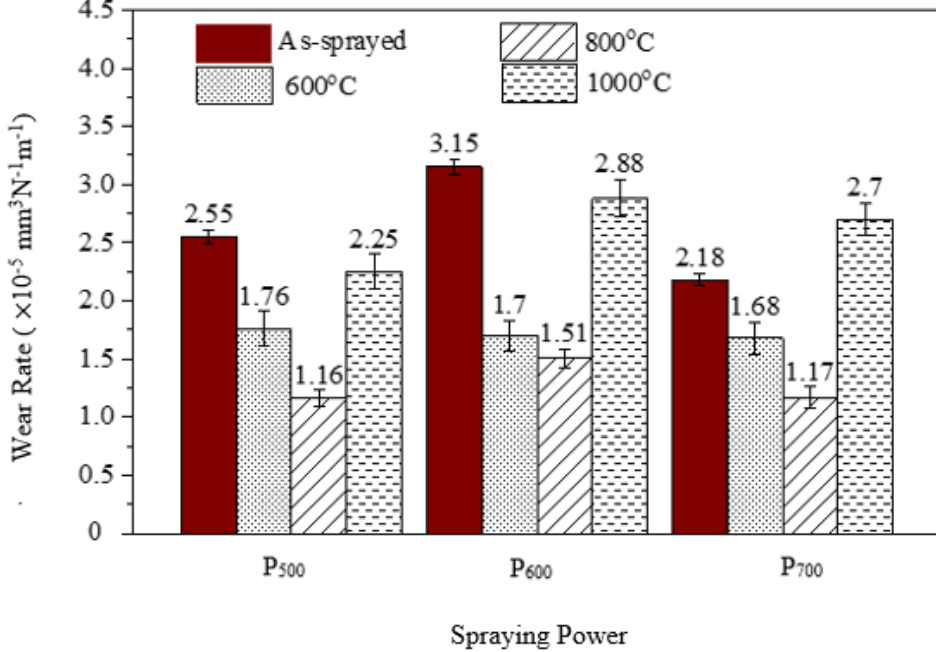
Figure 9. Volumetric wear rate of the as-sprayed and heat treated Al 0.5 CoCrFeNi 2 Ti 0.5 HEA.